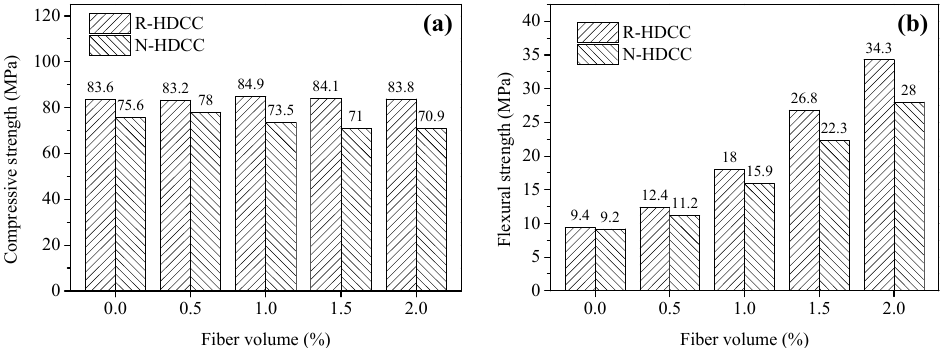
Figure 9. Comparison of strength between R-HDCC and N-HDCC: ( a ) Compressive and ( b ) Flexural. For specimens with 0%, 0.5%, 1.0%, 1.5% and 2.0% fiber, the flexural strengths of R-HDCC are 2.17%, 10.71%, 13.21%, 20.18% and 22.5% higher than those of N-HDCC, respectively. In